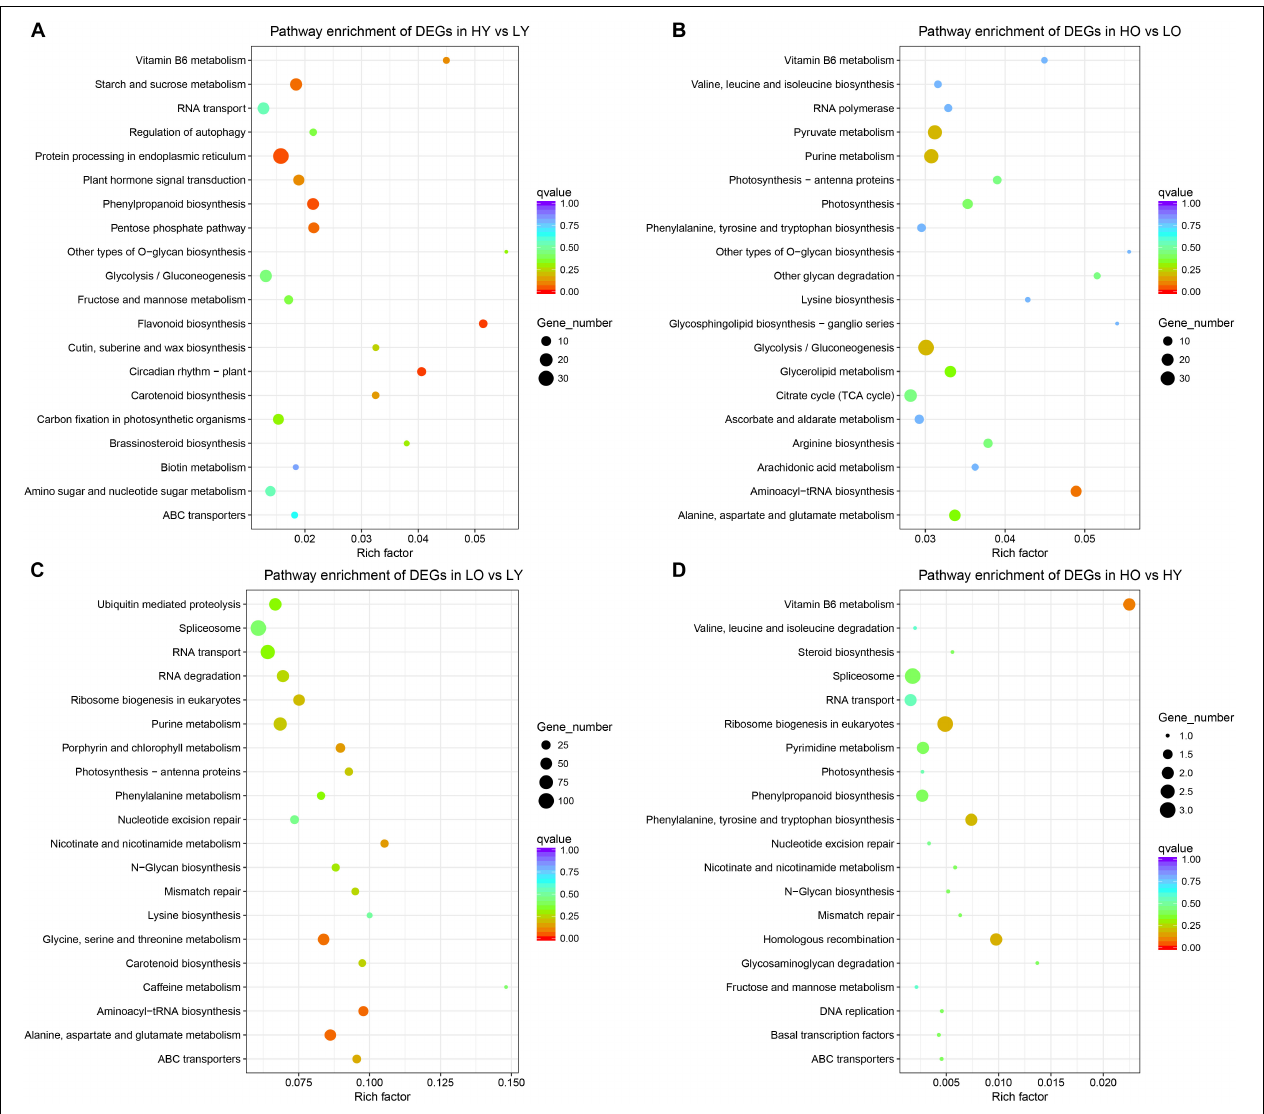
FIGURE 3 | KEGG pathway enrichment of all comparisons. (A) The most enriched KEGG pathways of DEGs in HY vs. LY. (B) The most enriched KEGG pathways of DEGs in HO vs. LO. (C) The most enriched KEGG pathways of DEGs in LO vs. LY. (D) The most enriched KEGG pathways of DEGs in HO vs. HY. The rich factor stands for the ratio of the DEGs number and the number of genes annotated in this pathway. The larger of the rich factor means the greater degree of